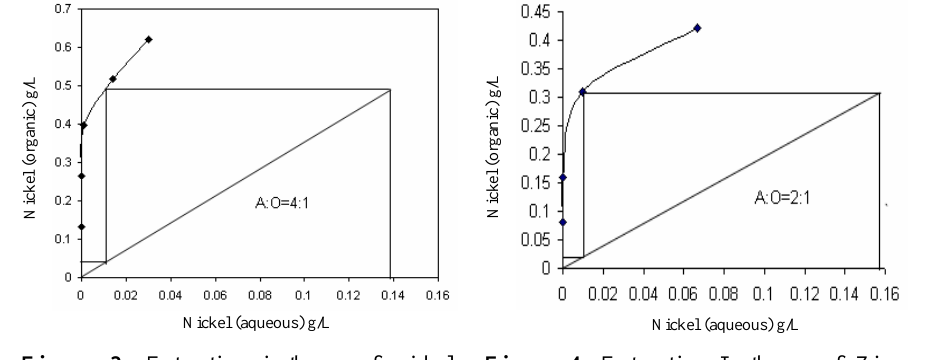
Figure 4. Extraction Isotherm of Zinc. Aqueous phase: Nickel raffinate. Organic phase: 0.05 M LIX 984N. Equilibrium pH=8.8. Contact time: 20